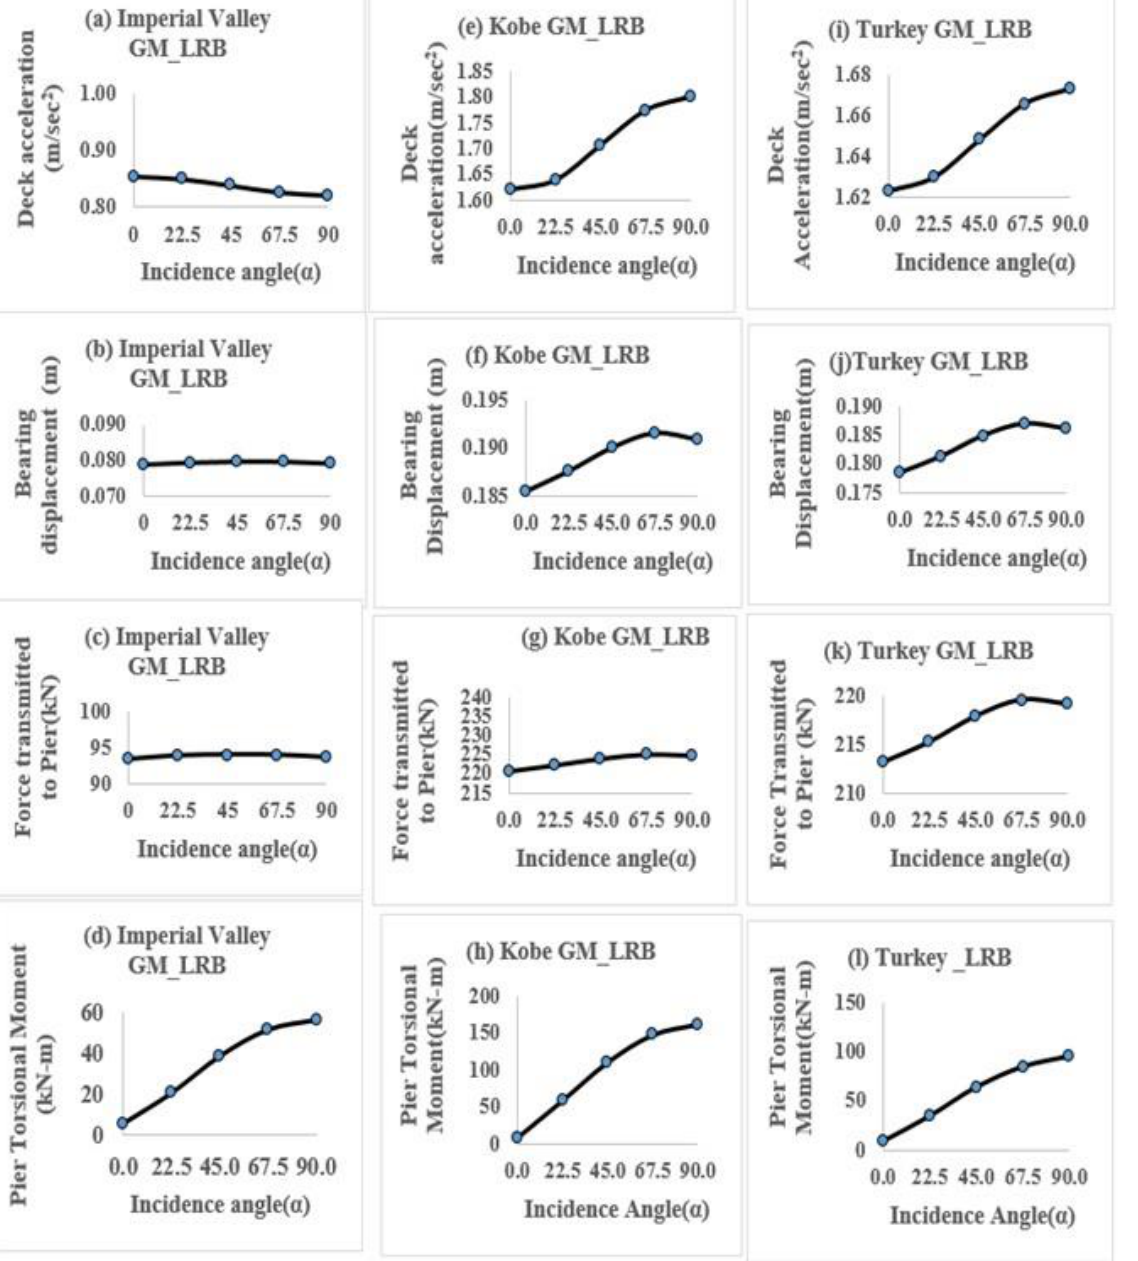
Figure 8. Effect of incidence angle (α) on response parameter of the isolated bridge under bi-directional Imperial Valley ( a – d ), Kobe ( e – h ), and Turkey ( i – l ) Ground Motions.